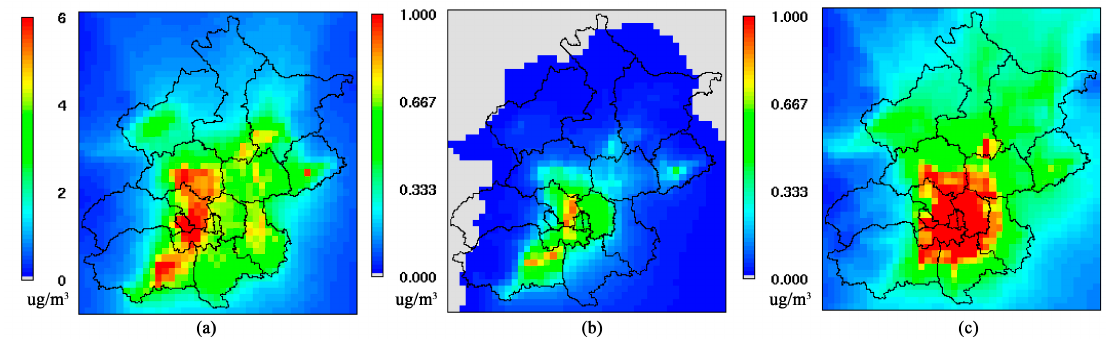
Figure 6. Spatial distribution of PM 2.5 concentration reduction caused by control measures in coal combustion ( a ), industry ( b ) and motor vehicle ( c ).